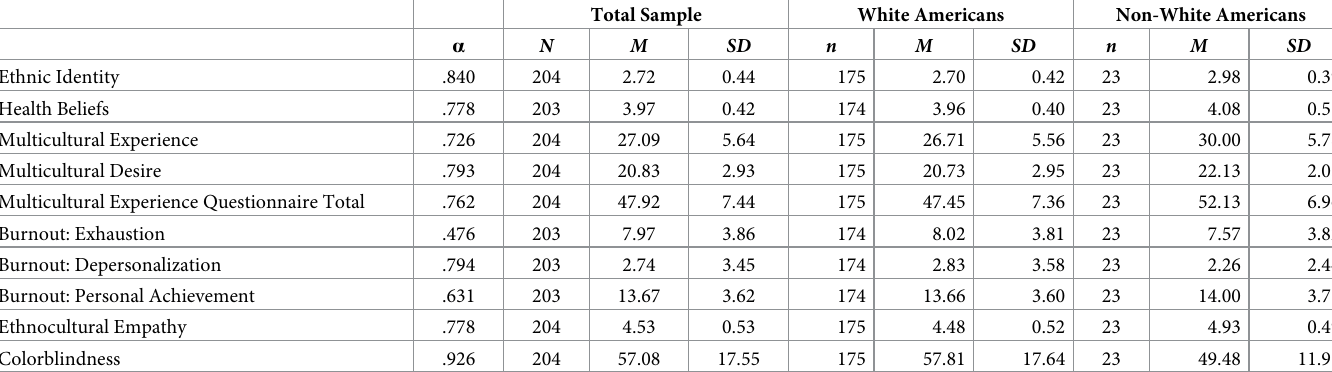
Table 1. Mean and standard deviations for cultural competence constructs across groups.